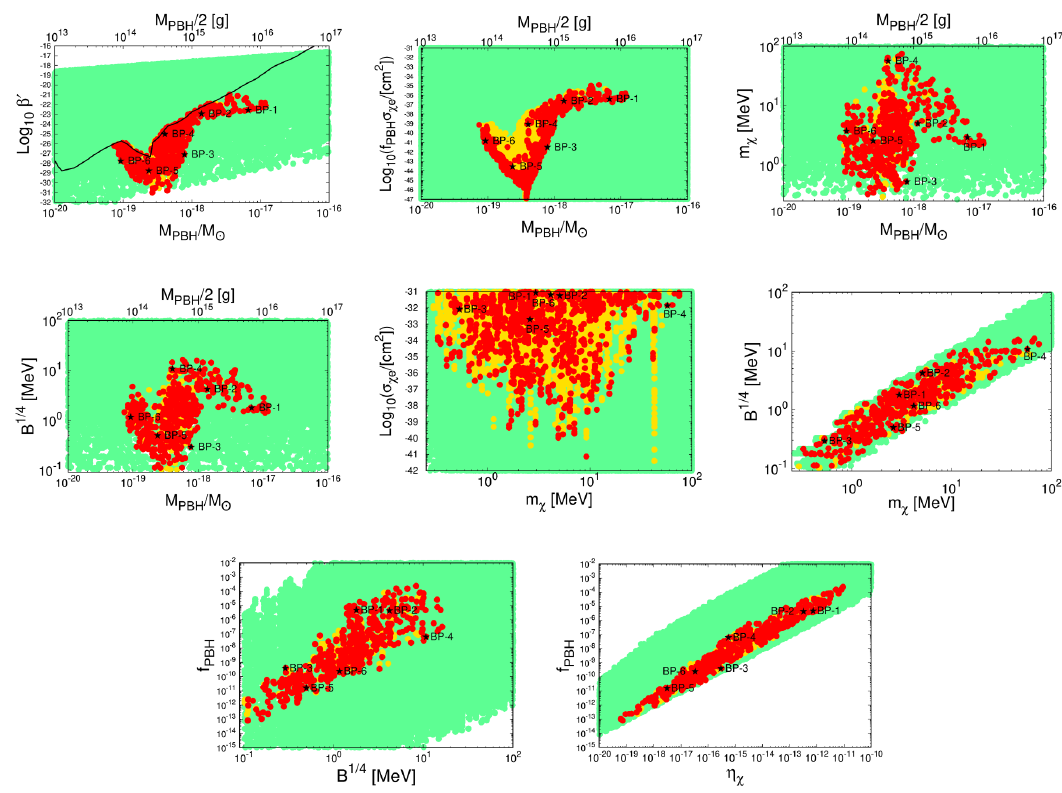
Figure 1 . The parameter space in which a GW signal can be detected at THEIA/ µ Ares is shown with green points. The yellow points are excluded by current XENON1T/XENONnT/SK data at 2 σ , and the red points are consistent with these data at 2 σ , but can produce a 2 σ DM signal in future XENONnT/HK data and a GW signal at THEIA/ µ Ares. The solid black curve in the top left panel shows the current bound from observations of the extragalactic gamma-ray background and from the damping of small scale CMB anisotropies. The stars mark the six benchmark points in table 1. All points satisfy Ω PBH h 2 ≤ 0 . 12 and ∆ N eff ≤ 0 . 5